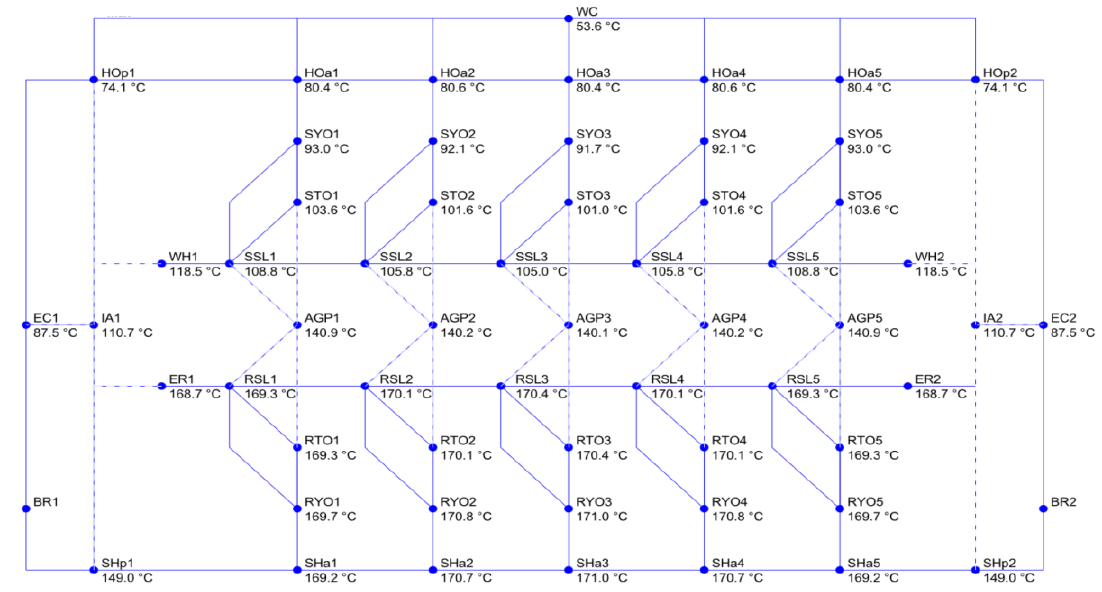
Figure 12. Thermal modeling results of the IM for the NEmo at 6000 r/min and 34 N·m.